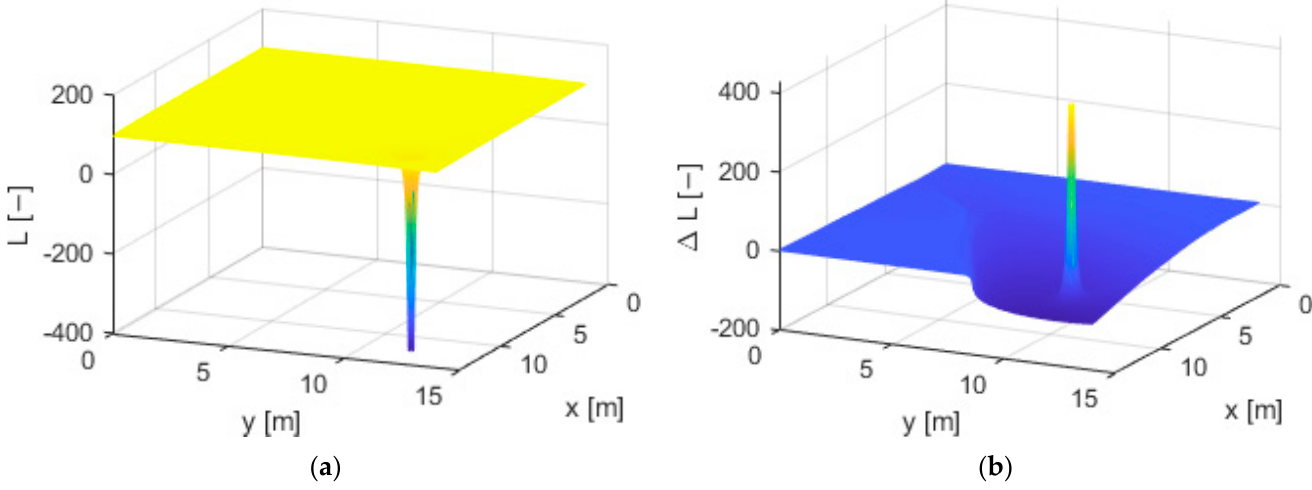
Figure 15. ( a ) Results of the Lyapunov function 𝐿 in the entire navigation area for Agent J; ( b ) Results of the Lyapunov incremental function ∆𝐿 over the entire navigation area for Agent J.